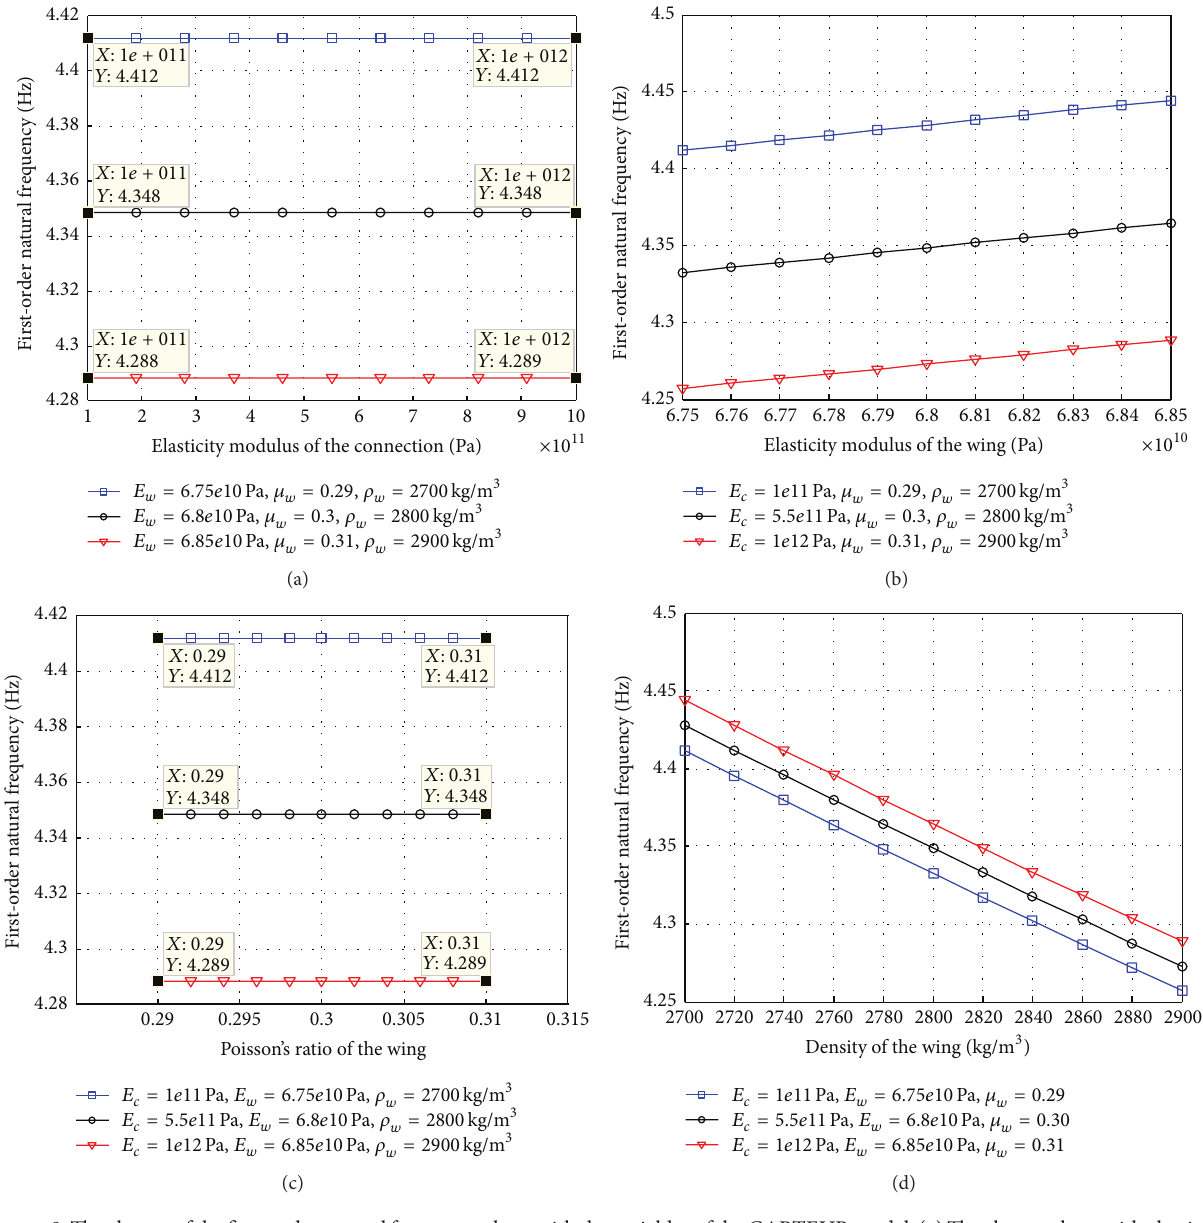
Figure9:Thechangeofthefirst-ordernaturalfrequencyalongwiththevariablesoftheGARTEURmodel.(a)Thechangealongwithelasticity modulus of the connection. (b) The change along with elasticity modulus of the wing. (c) The change along with Poisson’s ratio of the wing. (d) The change along with density of the